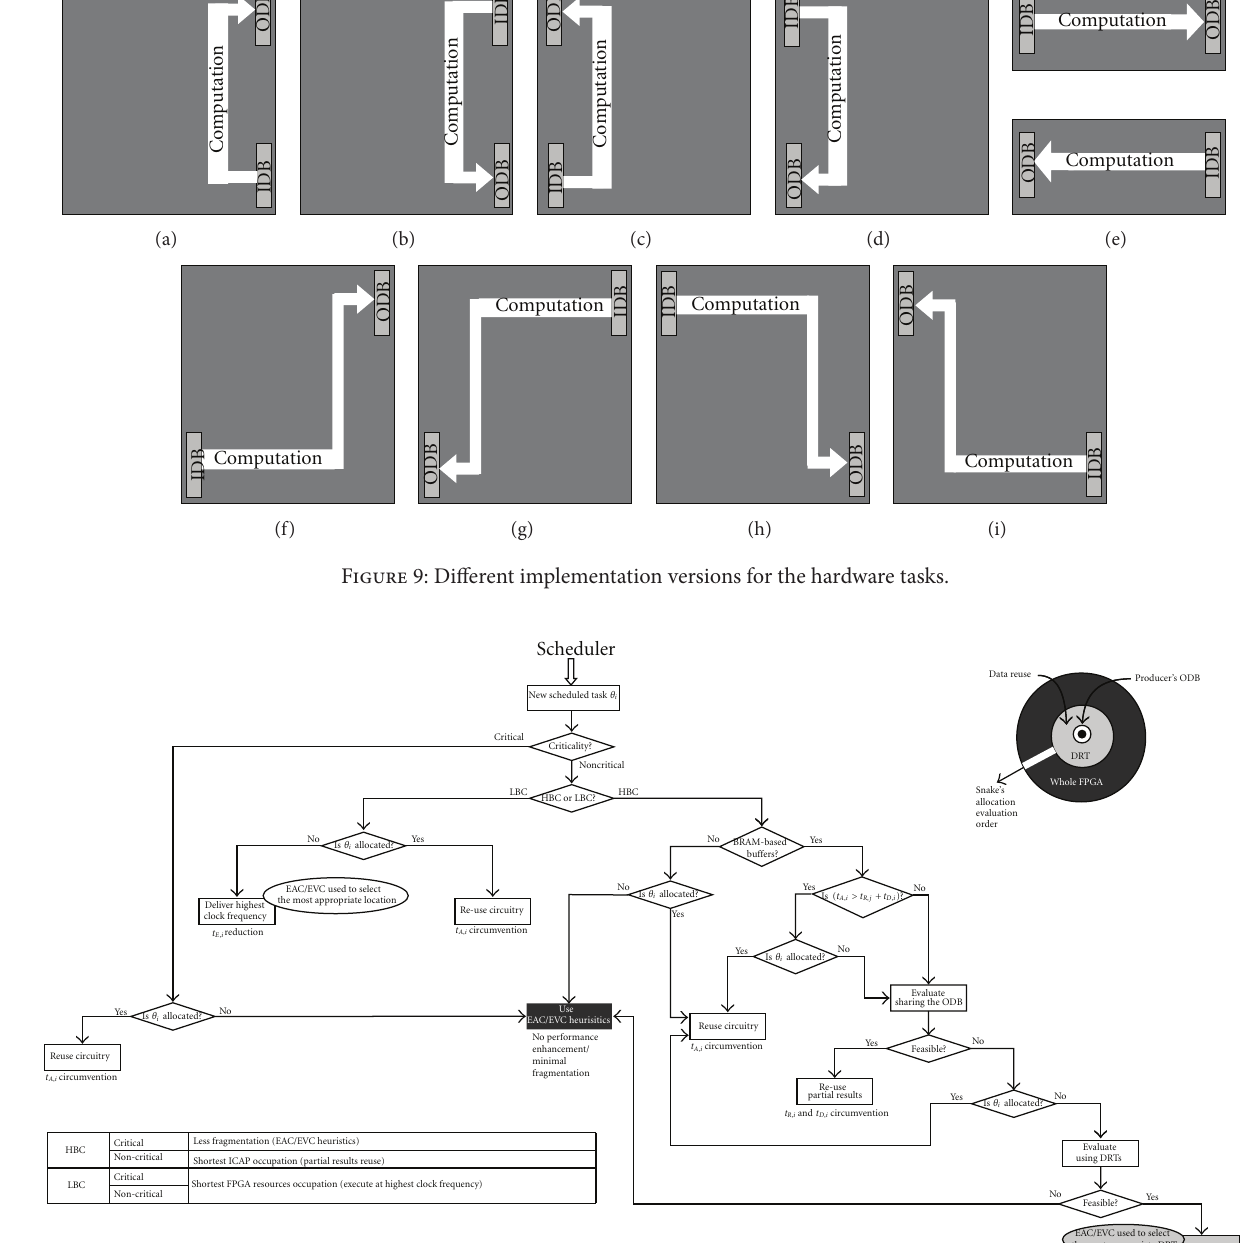
Figure 10: Snake task allocation